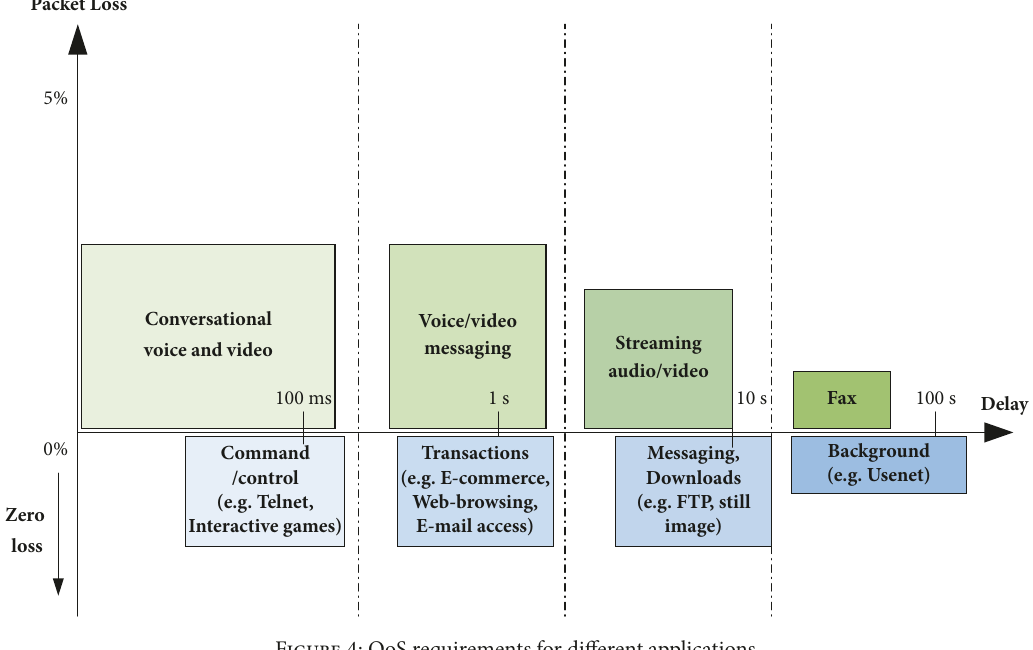
Figure 4: QoS requirements for different applications.